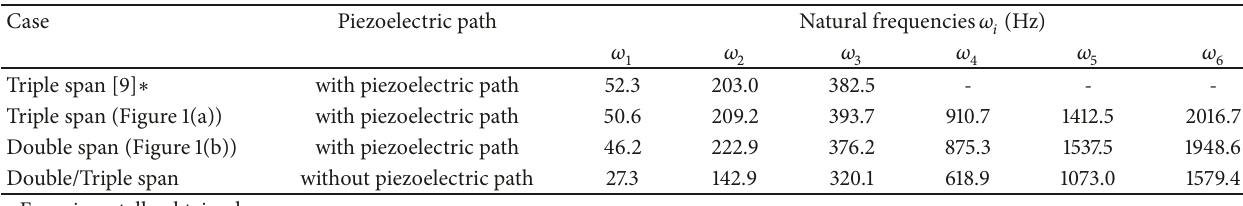
Table 2: Comparative natural frequencies between cases of double and triple span beams with and without piezoelectric patch on the first